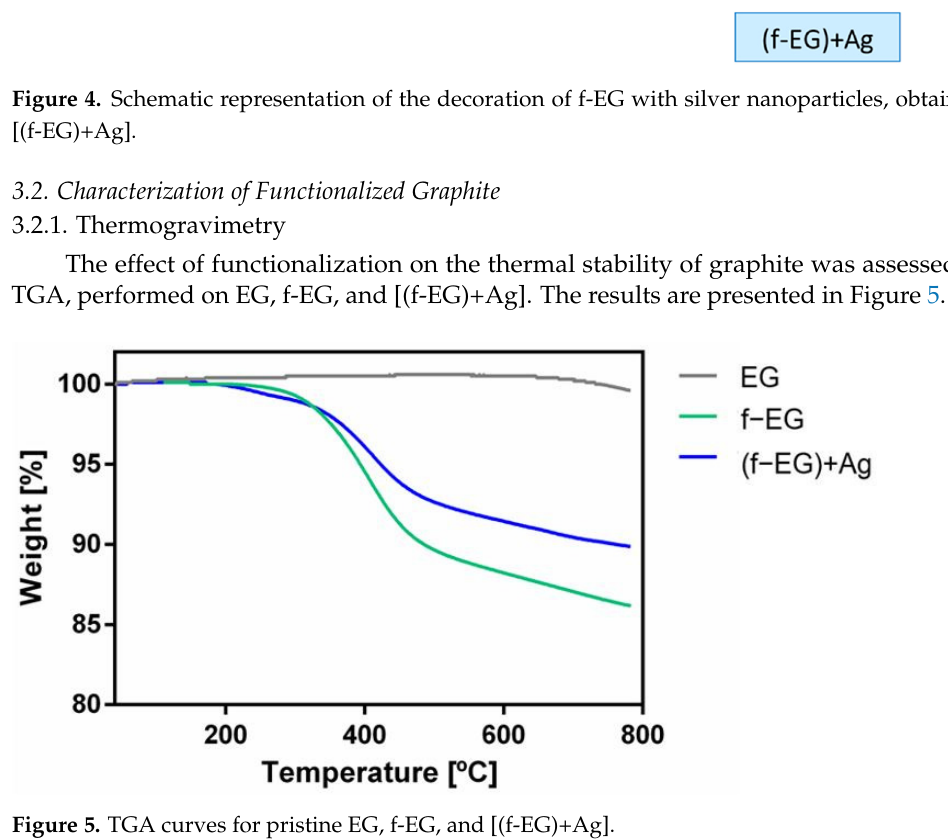
Figure 4. Schematic representation of the decoration of f-EG with silver nanoparticles, obtaining [(f-EG)+Ag].